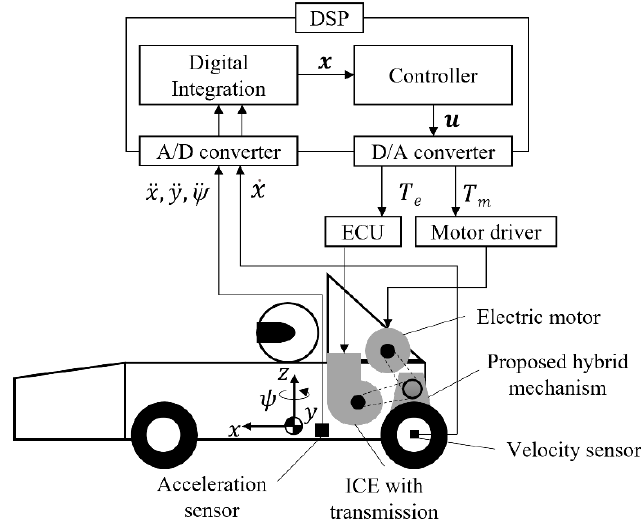
Figure 2. Outline of proposed hybrid racing car.